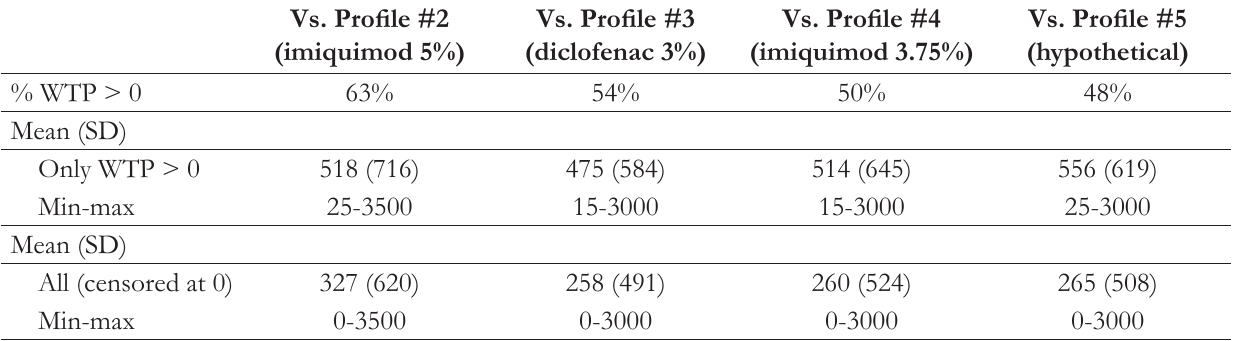
Table 2. Incremental WTP for Treatment with the Ingenol Mebutate Gel Profile instead of Competitor Profiles, US$